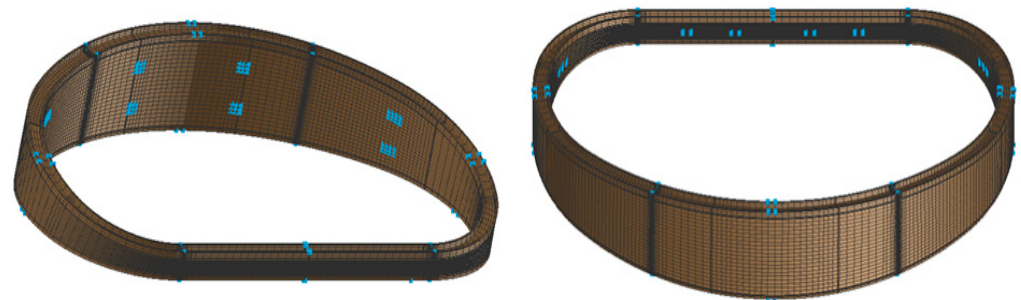
Figure 15. Constraint conditions in the practical production process of the 1/32 VV mock-up.